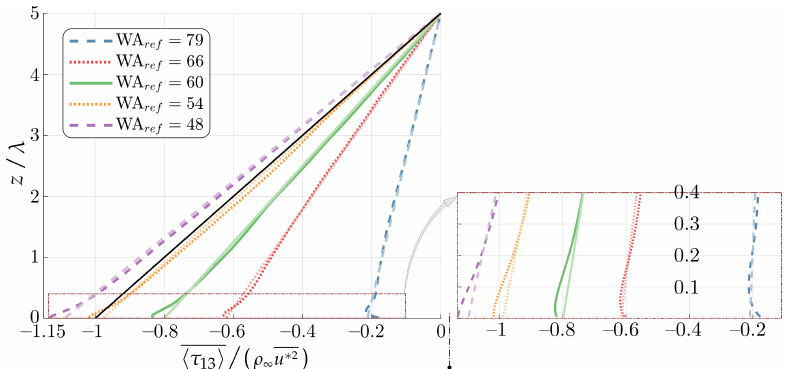
Figure 12. Total shear stress, averaged with t avg = 75 T 0 . Linear fittings are shown as transparent lines, parameterized according to Table 3. The black line represents the theoretical flat-bottom solution. The fitting is less accurate in the near-wall region, zoomed in the lower right corner.